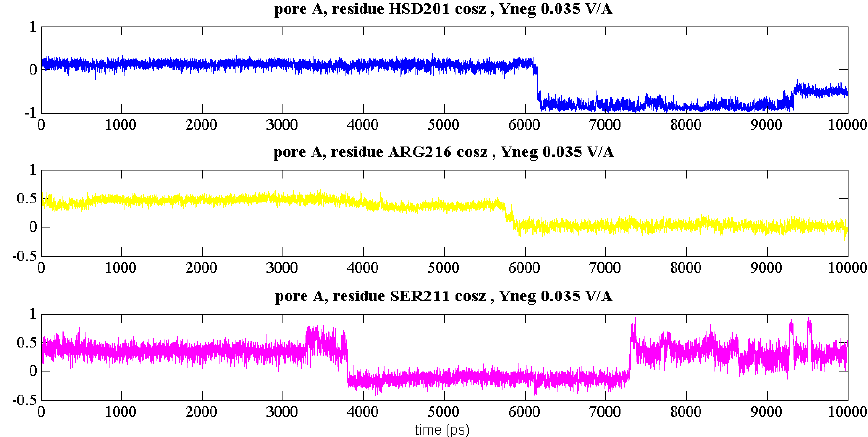
Figure 6. Representative evolution of cos θ in pore A at the “upper” gate for HSD-201, ARG-216 and SER-211 (see Figure 2) under a static field 0.035 V/Å oriented along the − y -axis.